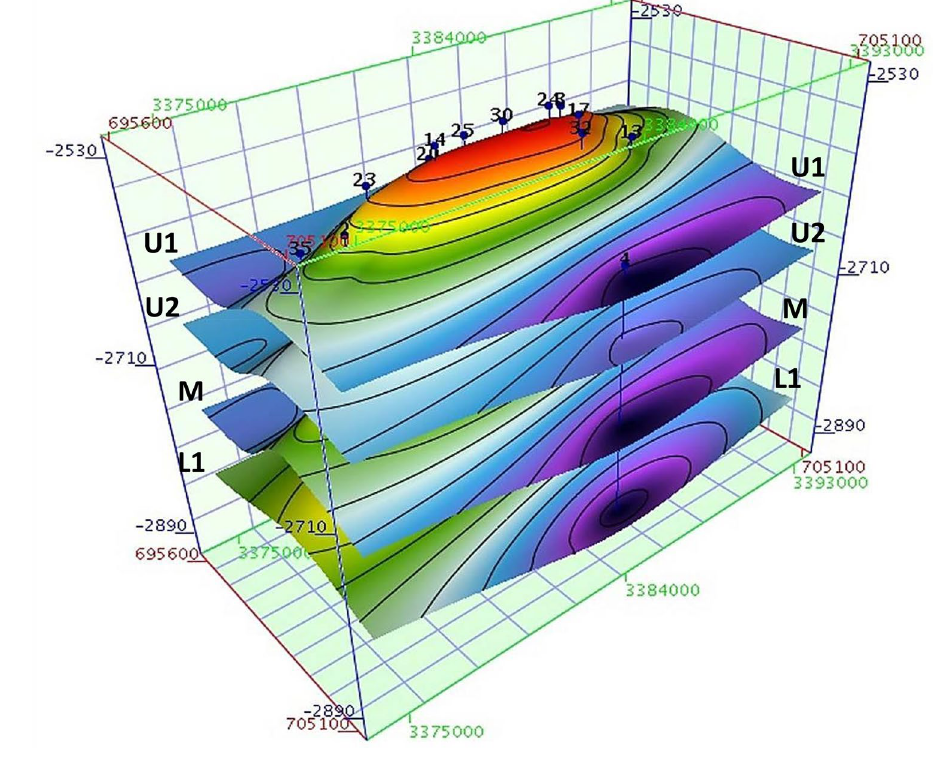
Fig. 14 3D-structural contour maps on top surfaces of the Albian reservoir units (U1, U2, M, and L1 units) in the SWM field